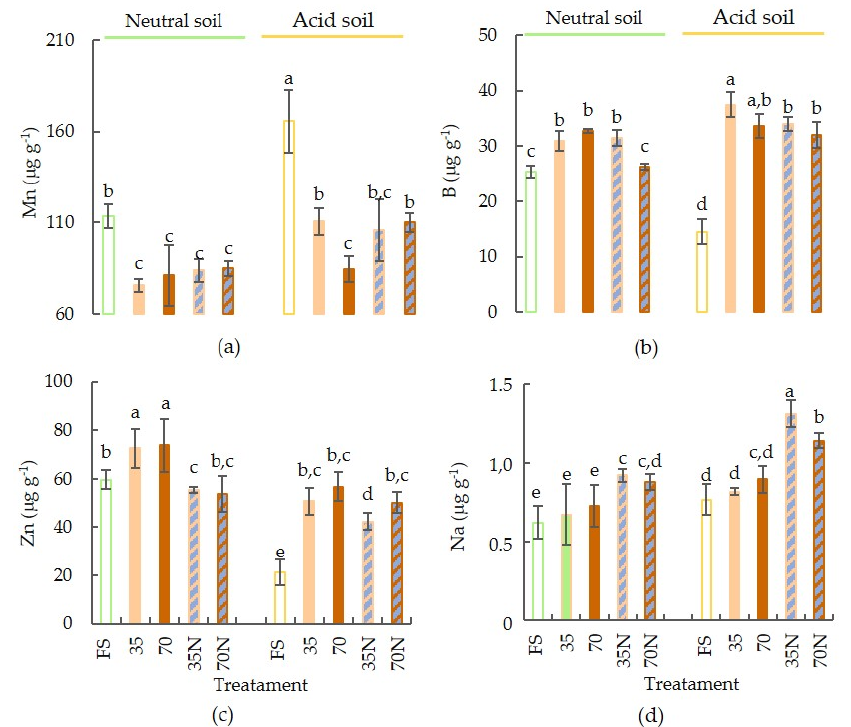
Figure 6. Effects of soil and MSWC supplemented or not with inorganic nitrogen on shoot Mn ( a ), B ( b ), Zn ( c ) and Na ( d ) concentrations. Note: FS—fertilized soil; 35—35 t MSWC ha − 1 ; 70—70 t MSWC ha Means with different letters are significantly different at p < 0.05. Each bar represents the mean of six replicates, while the error bars represent ±